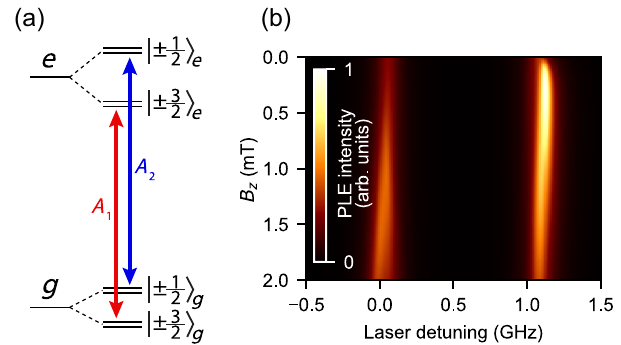
FIG. 8. V level structure and PLE. (a) Optical transitions are Si linearly polarized parallel to the c axis. The excited state zero- field splitting (1 GHz) is wider than the optical transitions, whereas the ground-state splitting (70 MHz) is close to the optical linewidth. The Land´e g factors are the same for the excited and ground-state manifolds. As such, the optical spectrum appears as 1 . 5 mT and two transitions [19,26]. (b) Simulated PLE for B x ¼ variable B (parallel to the c axis). The relative brightness of the z A 1 and A 2 transitions can be controlled with magnetic field through interference arising from the fine structure of the spin